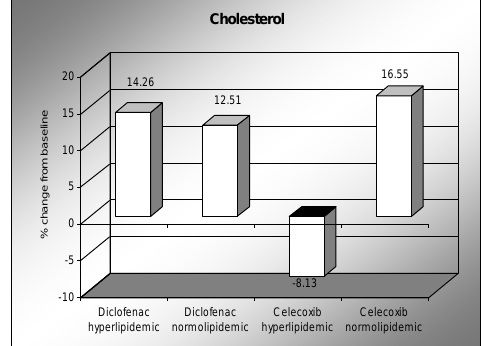
Figure (3):- The % changes in serum HDL- cholesterol concentration from baseline valuet after 8weeks treatment with diclofenac or celecoxib in hyperlipidemic and normolipidemic type 2 diabetic patients